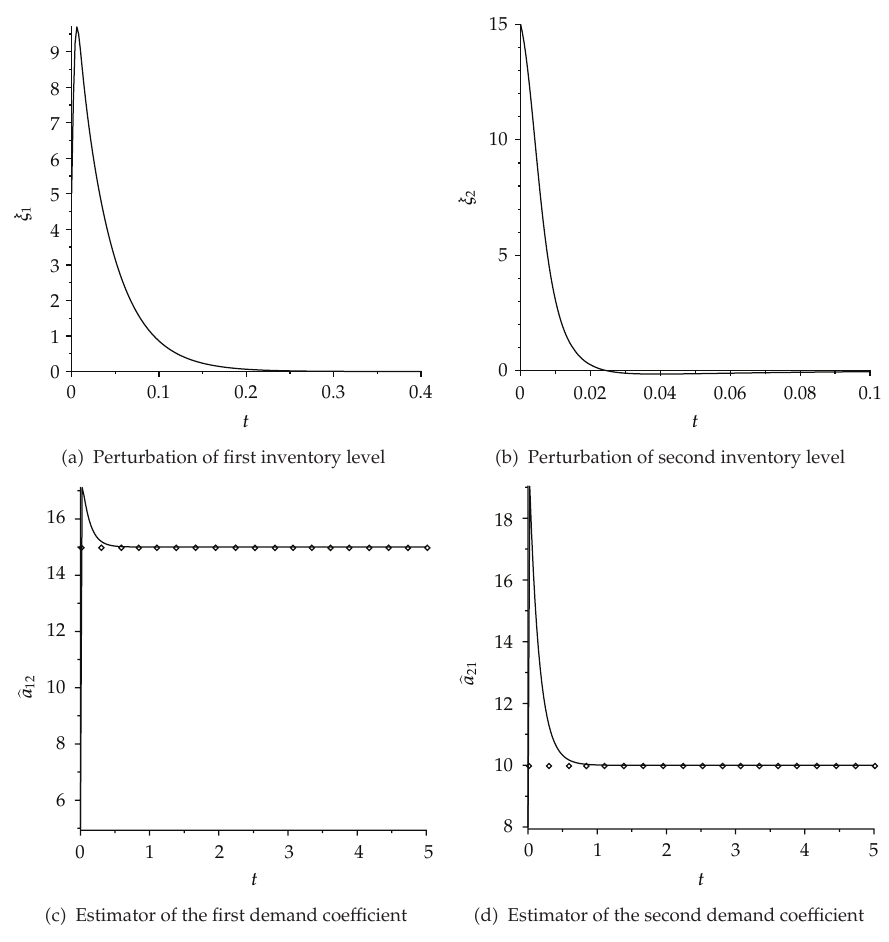
Figure 4: (cid:6) a (cid:7) and (cid:6) b (cid:7) are the perturbation of the first and second inventory levels about their inventory goal levels as the demand rate is a linear function of the inventory level. (cid:6) c (cid:7) and (cid:6) d (cid:7) are the di ff erence between dynamic estimators of the first and second demand rates and their real values.